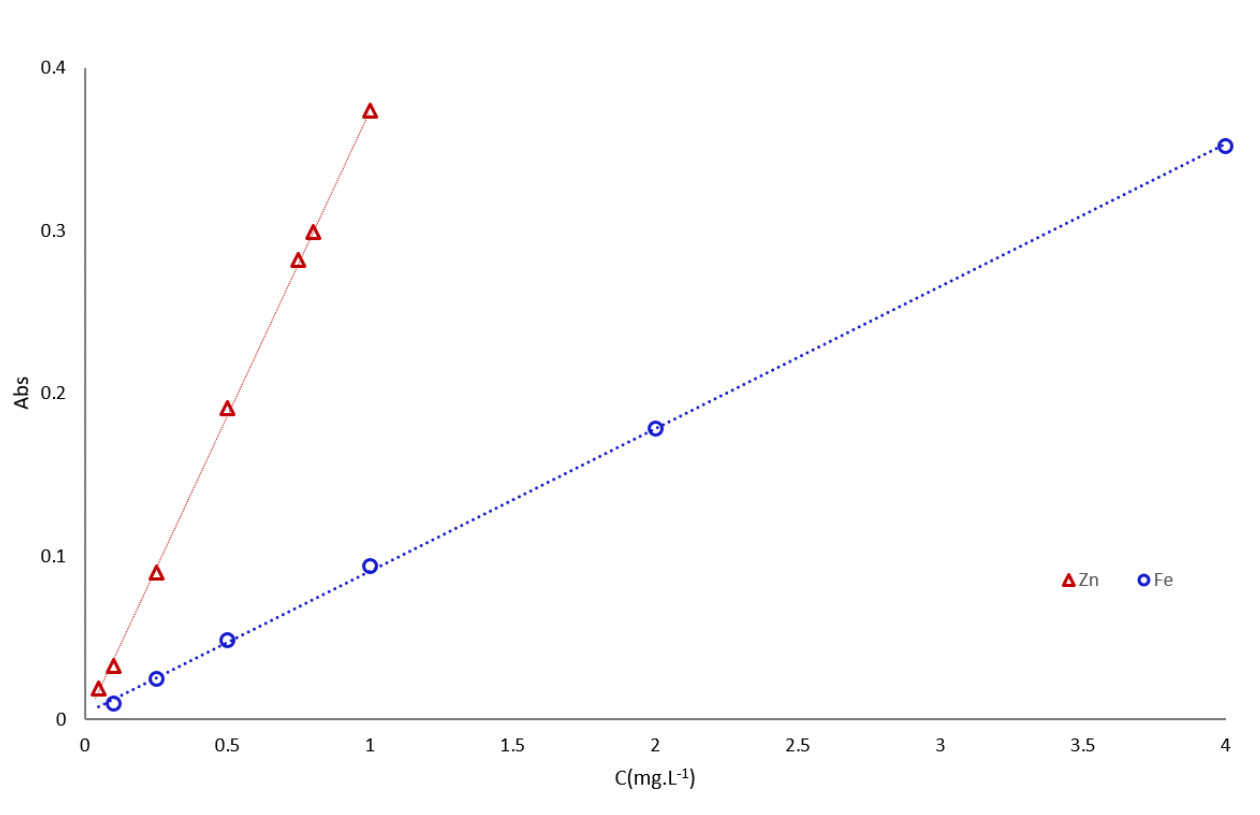
FIGURE 1 - Iron and zinc calibration